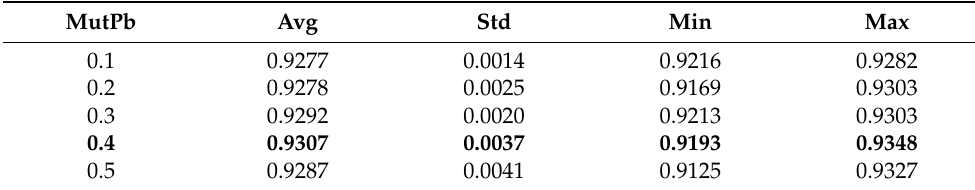
Table 7. Results varying the value of mutation probability (MutPb).